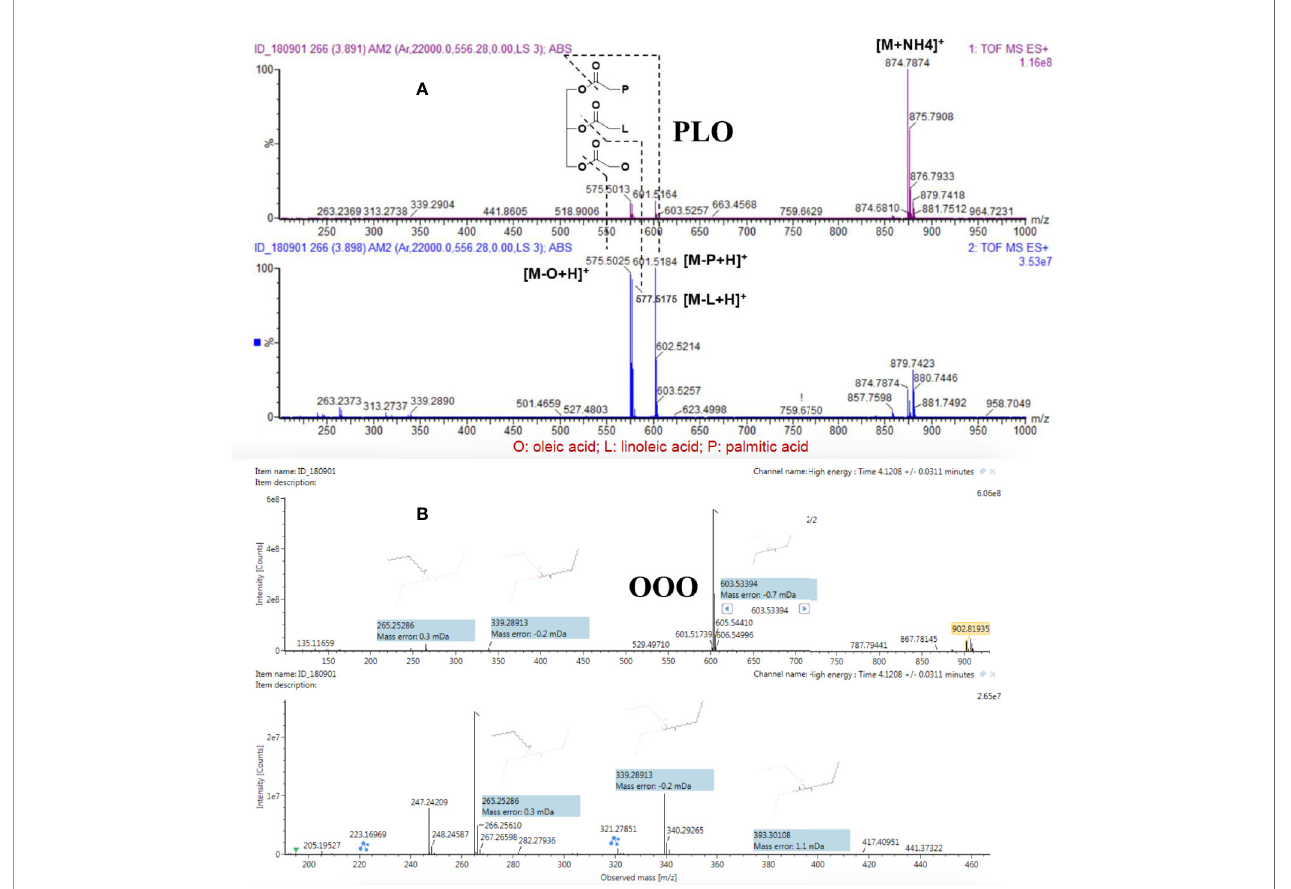
FIGURE 2 | Fragmentation patterns of PLO (A) and OOO (B) with MS1 and MS2 spectra.